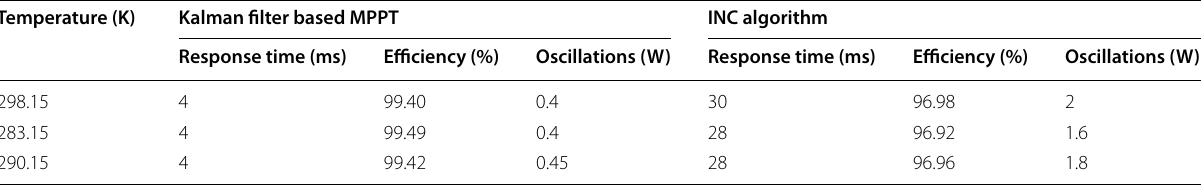
Table 3 Results comparison between the proposed method and INC algorithm at irradiance 500 W/m 2 Temperature